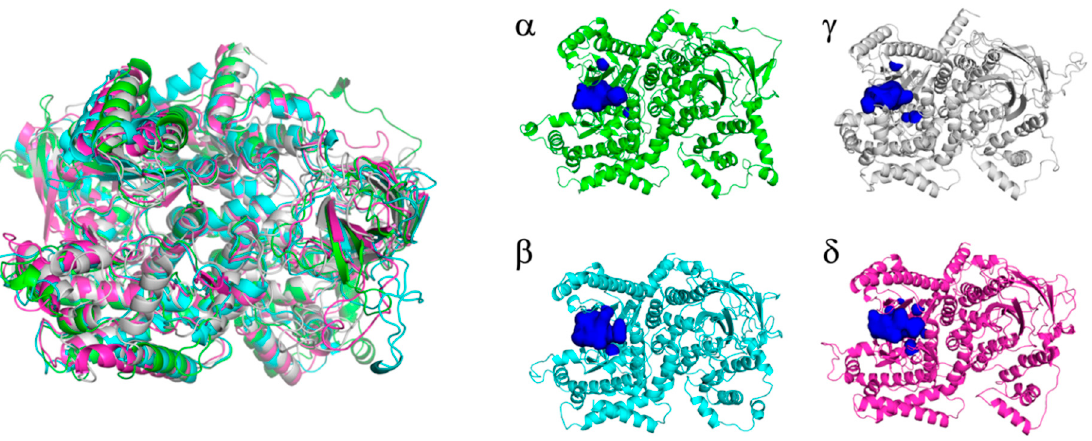
Figure 4. On the left, the structural alignment of the tertiary structures of PI3K α (green), PI3K β (cyan), PI3K γ (grey), and PI3K δ (magenta). On the right, activity pockets are highlighted as blue surfaces for each isoform.